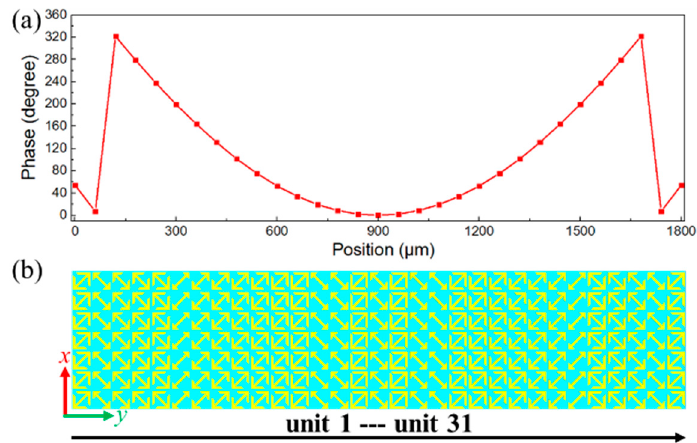
Figure 6. ( a ) The required phase compensations by step of 60 μ m. ( b ) The middle layer of the 1D metalens in x ‐ y plane (only the middle layer is depicted for clarity).